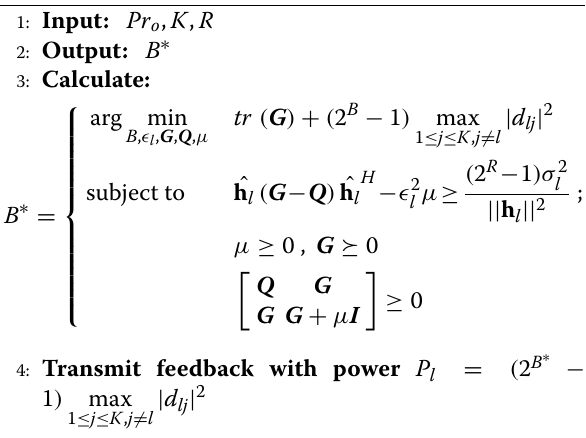
Algorithm 2 Feedback